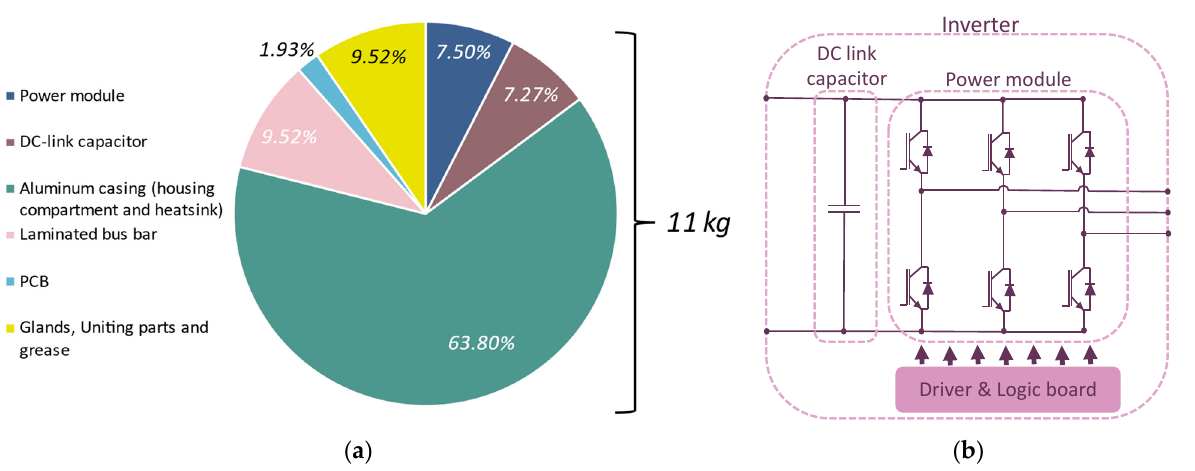
Figure 2. ( a ) Mass diagram of a 150 kW inverter with 450 V DC bus, total weight = 11 kg; ( b ) Electrical diagram.